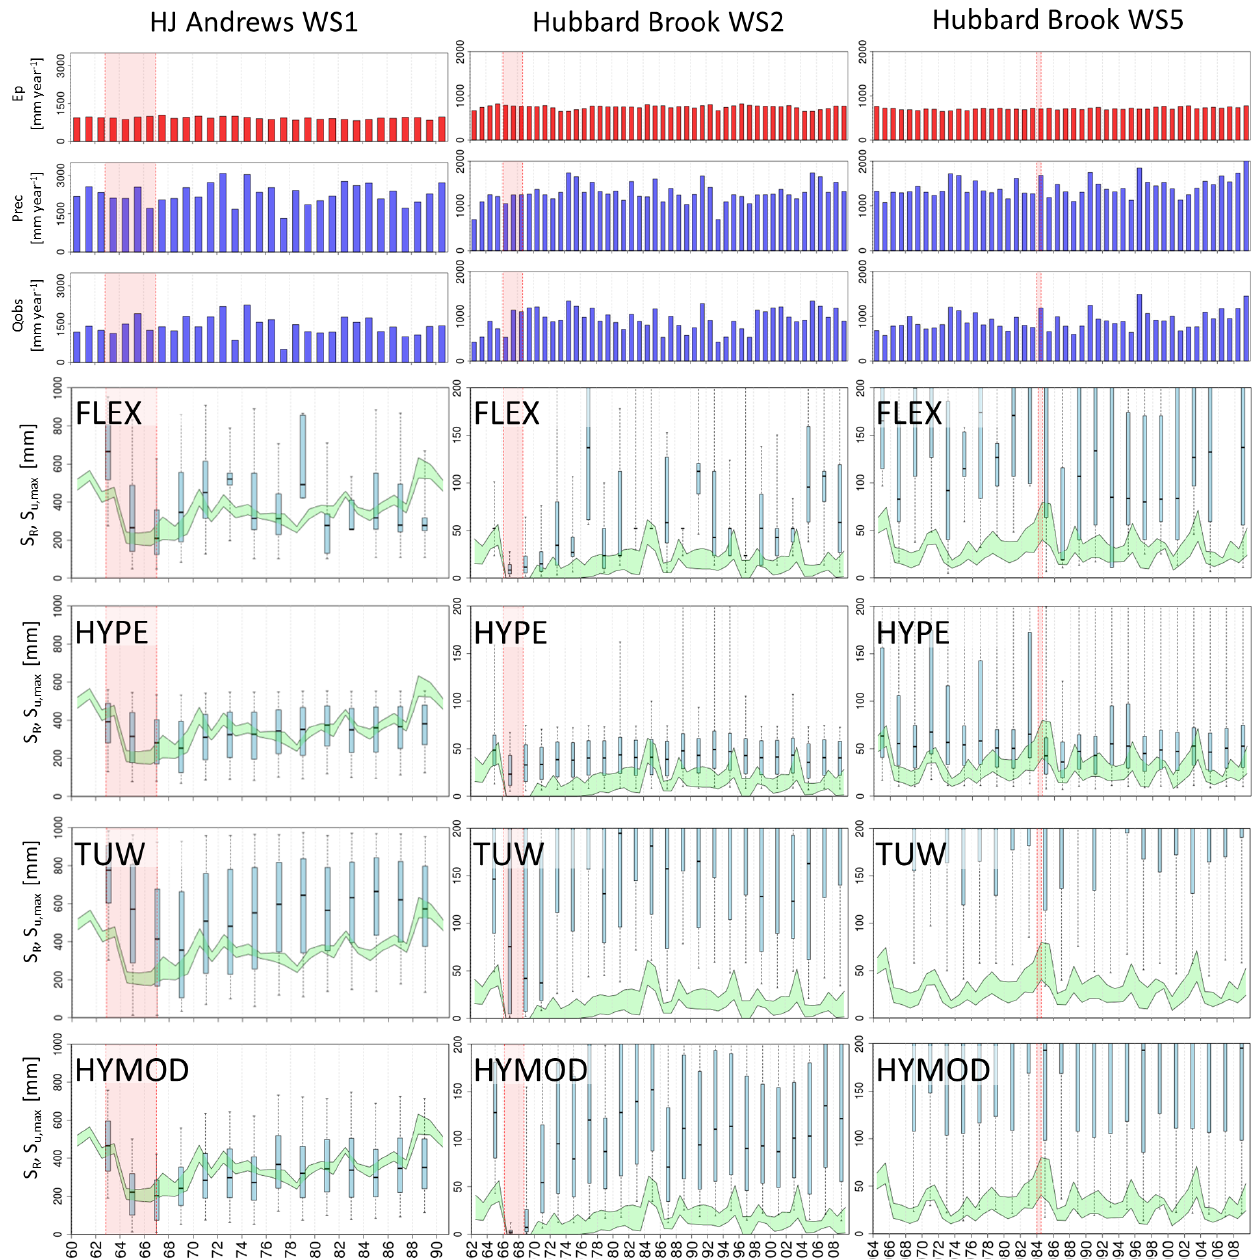
Figure 4. Evolution of root-zone storage capacity S R, 1 yr from water balance-based estimation (green shaded area, a range of solutions due to the sampling of the unknown interception capacity) compared with S u, max,2yr estimates obtained from the calibration of four models (FLEX, HYPE, TUW, HYMOD; blue box plots) for HJ Andrews WS1, Hubbard Brook WS2 and Hubbard Brook WS5. Red shaded areas are periods of